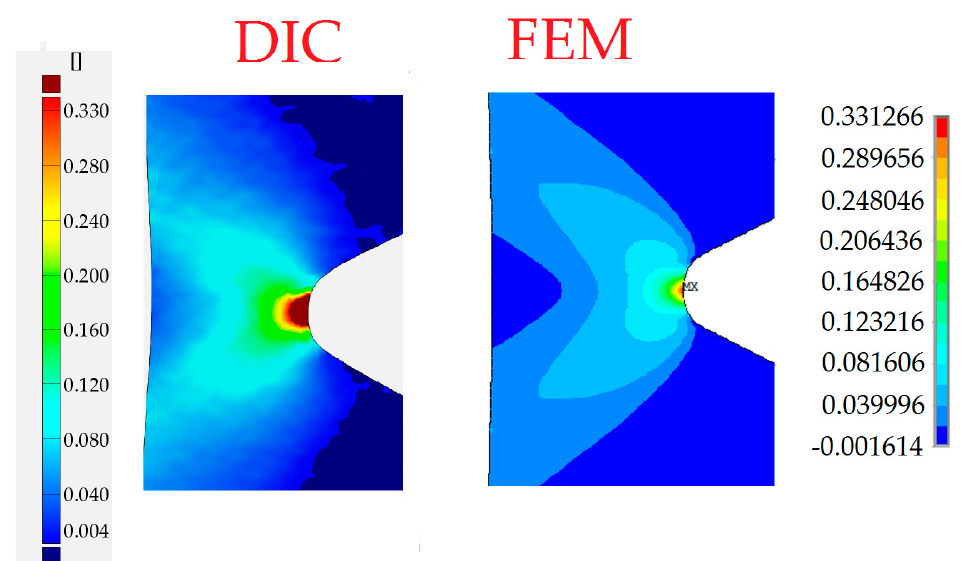
Figure 26. Comparison of DIC–GOM and finite element analysis results.